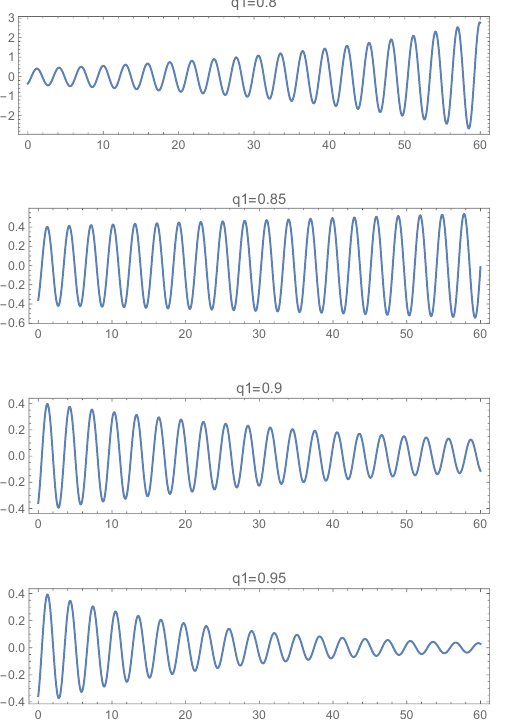
Figure 3. Numerical solutions of (14) for m = 1, c 1 = 1, c 2 = 0.1, c 3 = − 1, k 1 = 4 and k 2 = 1, for q 2 = 0.95 and several values of the fractional order q 1